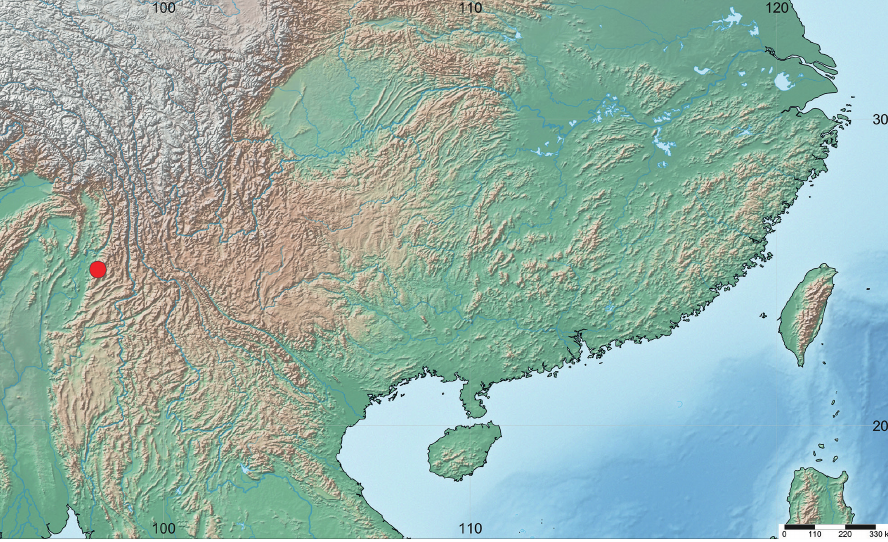
Figure 9. Distribution map of Cornonannus bui gen. et sp.